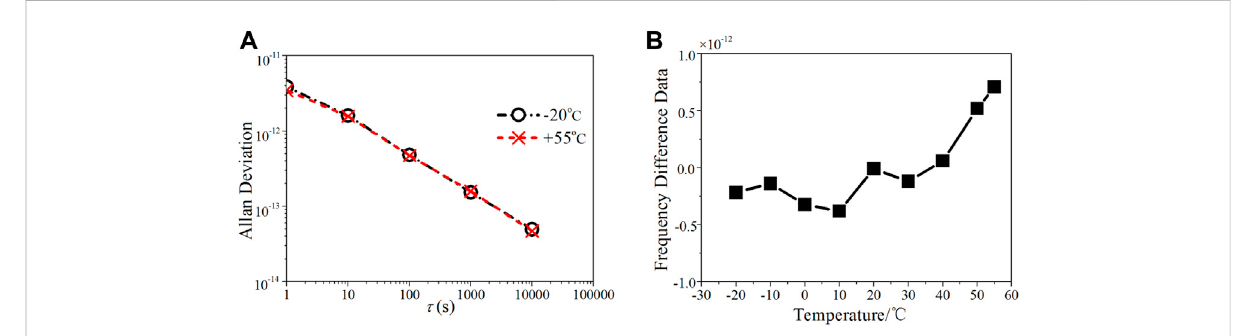
The frequency curves under the different working temperatures. (A) Frequency stability. (B) Relative frequency difference at different